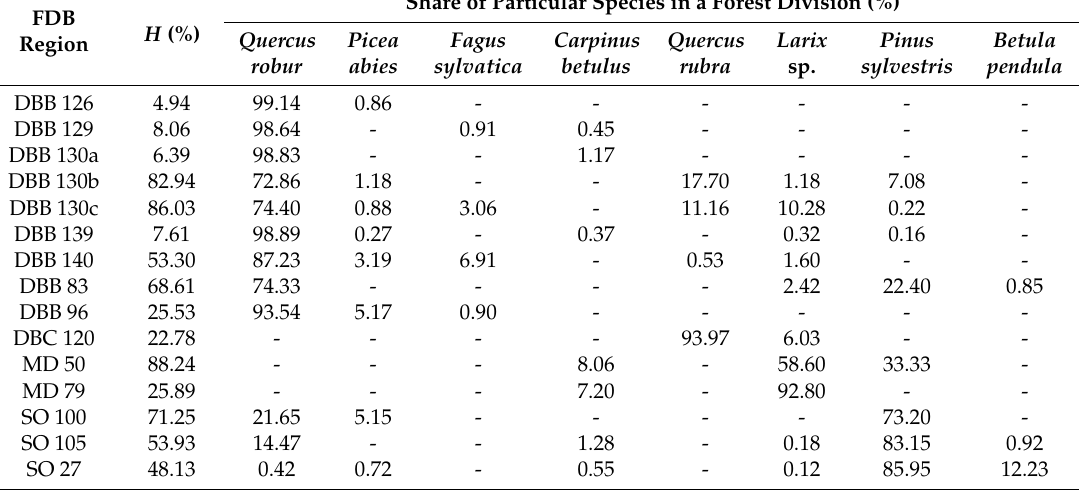
Table 2. Shannon-Wiener species diversity index ( H ) and the shares of the identified species in forest divisions (the results based on analyses of aerial images, see Section 2.4). Dominant species name with its age: DBB for Q. robur , DBC for Q. rubra , MD for Larix sp., SO for P. sylvestris . FDB: Forest Data